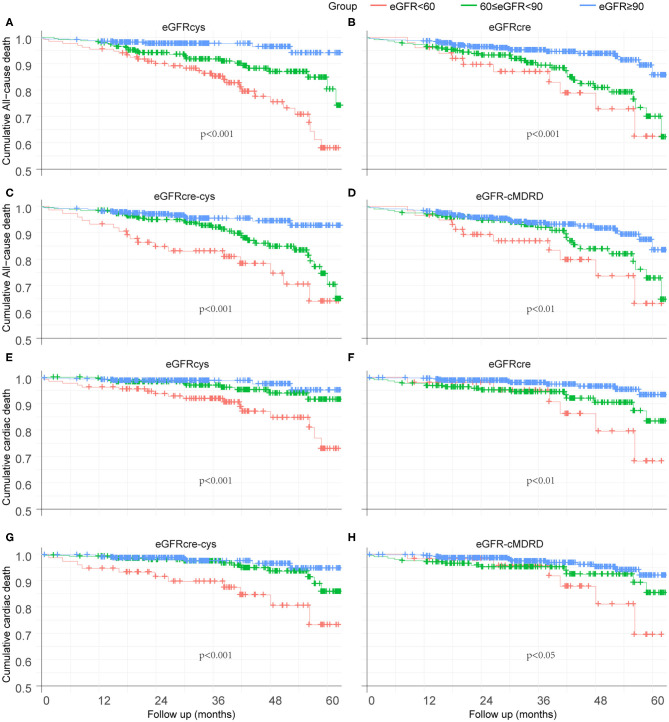
Kaplan–Meier curves to illustrate the survival free from adverse event. (A–D) Survival analysis of eGFRcys, eGFRcre, eGFRcre-cys, and eGFR-cMRDR for all-cause mortality, individually. (E–H) Survival analysis of eGFRcys, eGFRcre, eGFRcre-cys, and eGFR-cMRDR for cardiac death, separately. No. at risk = number of patients at risk for all-cause mortality or cardiac death.